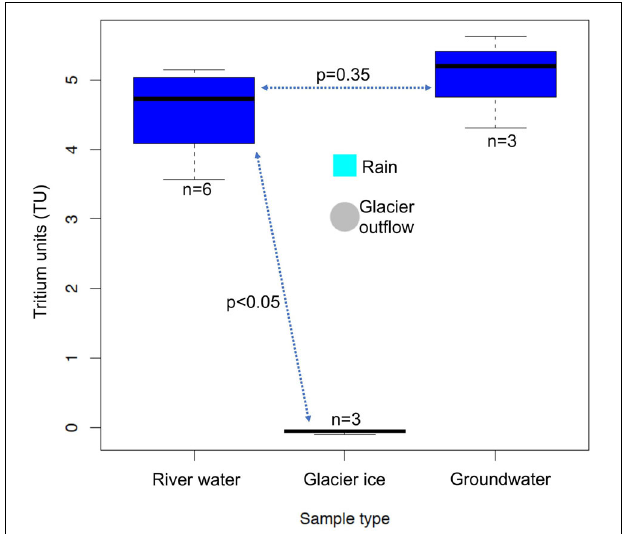
FIGURE 9 | August 2016 tritium presence across source waters and high elevation river water samples. Statistical relationships between sample types are noted by blue dotted lines: river water and glacier ice samples are statistically different ( p < 0.05) while river water and groundwater are not ( p =